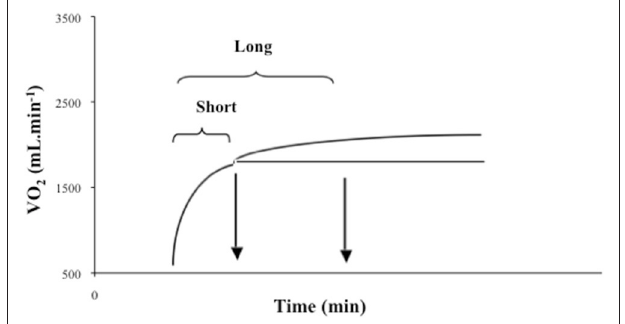
FIGURE 1 | Definition of the work intervals of the Short (beginning of the slow component) and Long (half duration of the slow component) intermittent